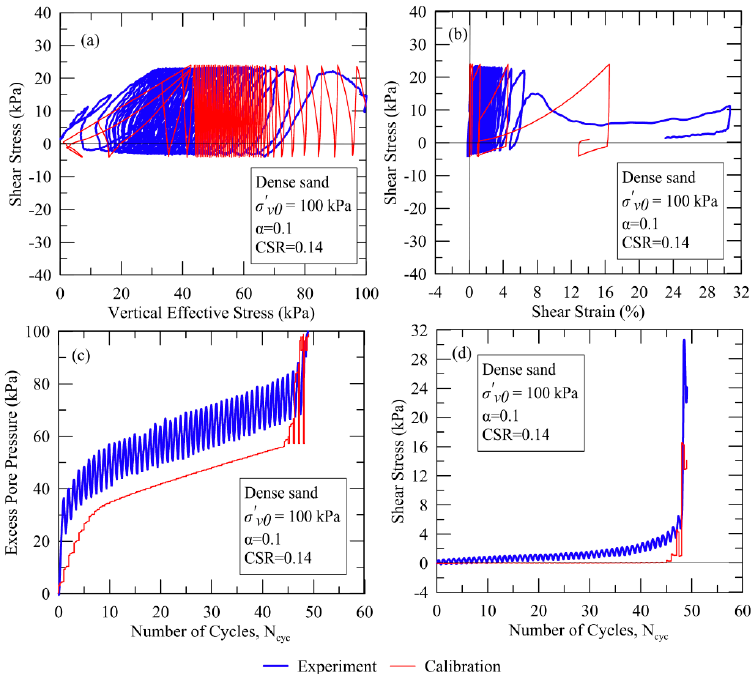
Figure 8. Comparison of the UBCSAND2 model for dense Pohang sand and laboratory CDSS test at CSR = 0.14, σ ´ v0 = 100 kPa, and α = 0.1 in the variations of (a) stress path, (b) shear stress–strain curve, (c) excess pore water pressure generation, (d) shear strain and number of cycles to liquefaction.